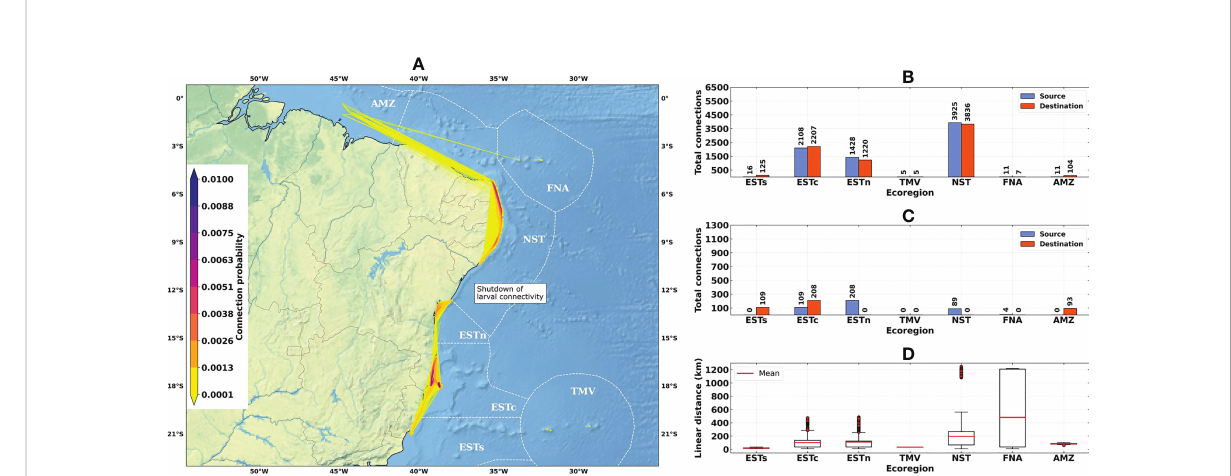
FIGURE 5 Connectivity patterns obtained from the larval connectivity model, considering the average of dispersal simulations between August – September – October for the El Niño years (1997 – 1998 and 2015 – 2016): (A) Distribution of connection probabilities between reef sites; (B) Total number of connections given source (in blue) and destination (in orange) ecoregions; (C) Number of connections given source (in blue) and destination (in orange) ecoregions, disregarding connections between reef sites within the same ecoregion; (D) Linear distances from connections between the source and destination reef sites. Ecoregions: Eastern-south (ESTs); Eastern-center (ESTc); Eastern-north (ESTn); Northeastern (NST), Amazon (AMZ), Fernando de Noronha-Atol das Rocas (FNA), Trindade-Martim Vaz Islands (TMV).